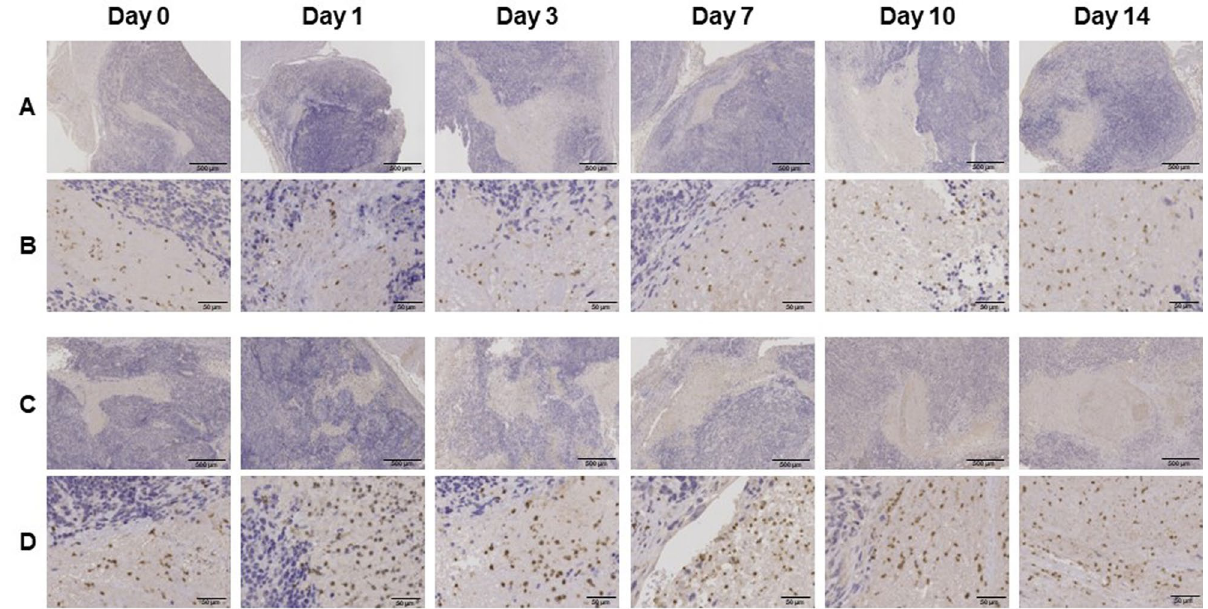
Figure 5. CD11b immunohistochemically stained sections of LNZ308 tumors after irradiation. The integrin alpha chain family member protein CD11b was used as a marker of inflammation. Tumors on right paws were irradiated on day 0 at the dose of 0 Gy ( A and B ) or 60 Gy ( C and D ). Photomicrographs of low ( A and C ) and high ( B and D ) magnification reveal CD11b stained tumor sections at days 0, 1, 3, 7, 10, and 14 after irradiation (N = 1 each treatment